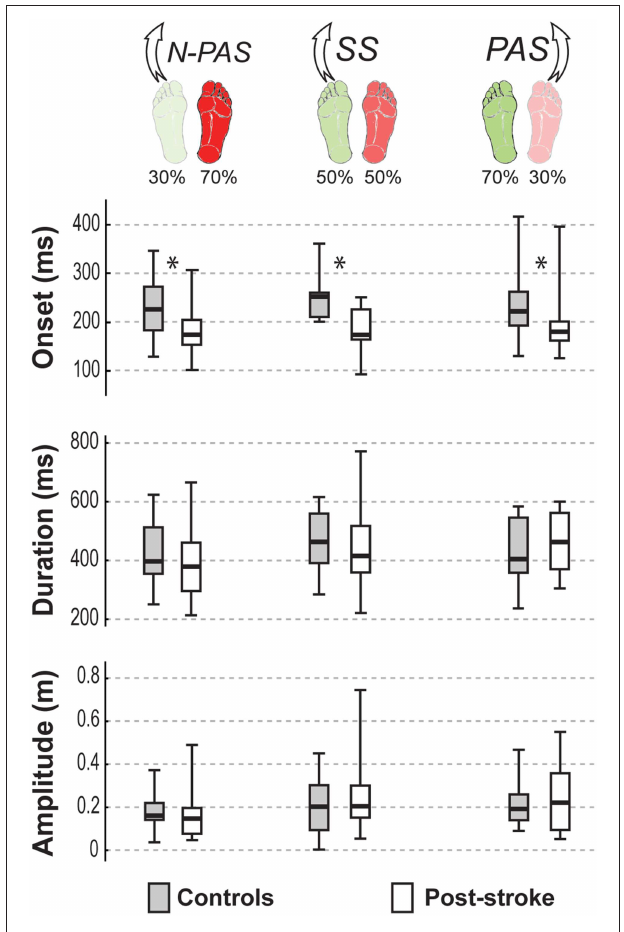
FIGURE 4 | APA characteristics by group. The median (thick line) of each anticipatory postural adjustment’s characteristics is presented for each group and each condition in which they were compared. Boxes represent 25 and 75th percentile. Bars represent min and max values. *Indicates a difference between groups at p <